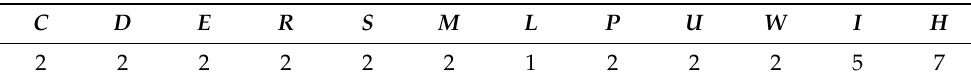
Table 3. The size for centers, products, and components.